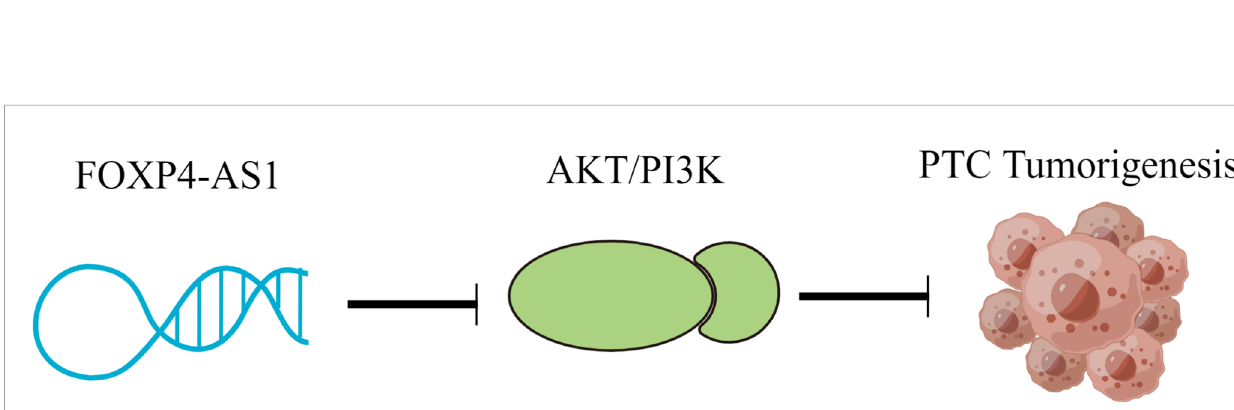
FIGURE 8 | Role of the FOXP4-AS1/PI3K/AKT signaling pathway in